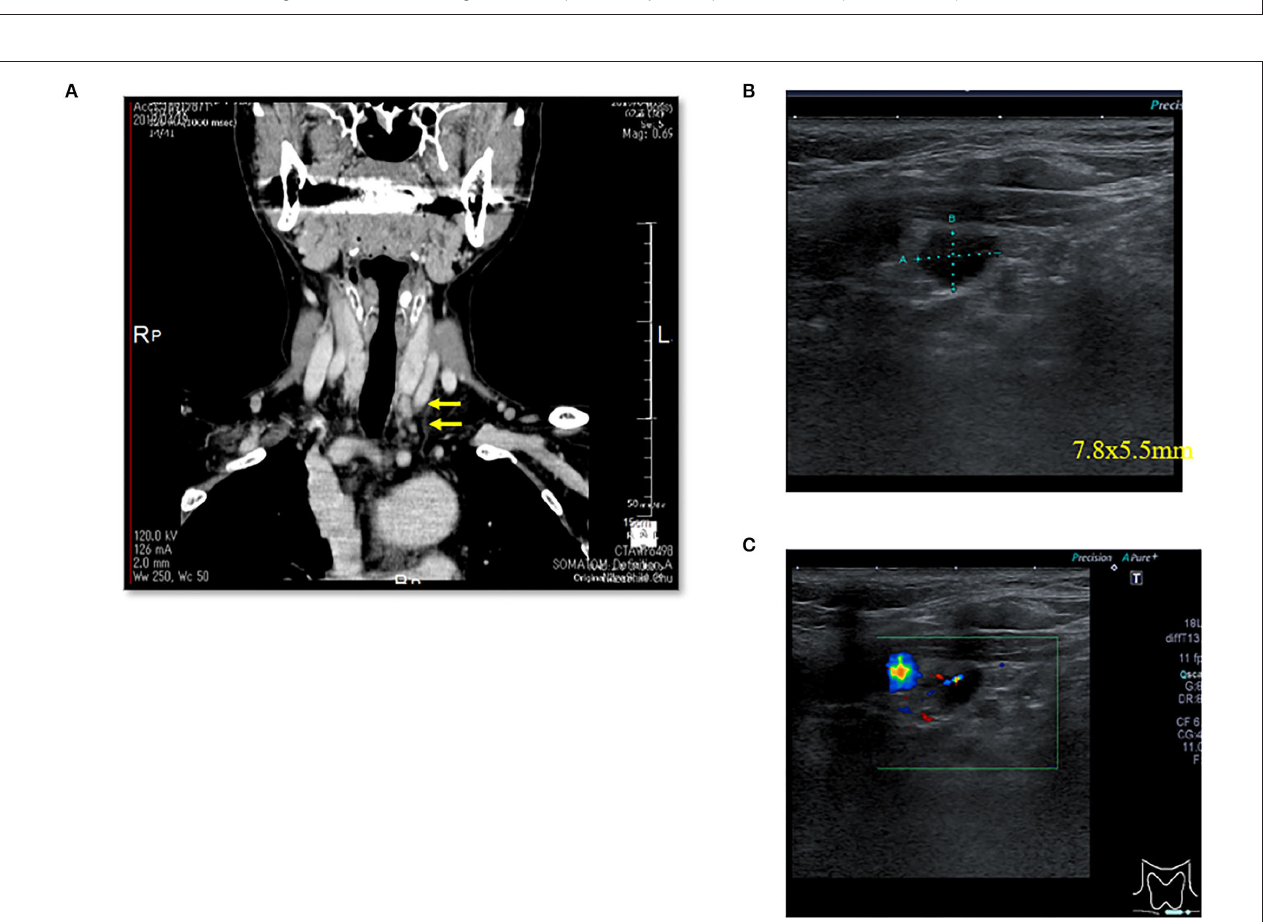
FIGURE 4 | Case 4. (A) Thoracic enhanced CT (MPR) scan showing a left lower thyroid mass (EPA: yellow arrow). (B) Cervical neck ultrasound showing a left lower thyroid mass [7.8 × 5.5mm (EPA)]. (C) Cervical neck ultrasound showing a left lower thyroid mass (EPA) and blood flow by color Doppler.